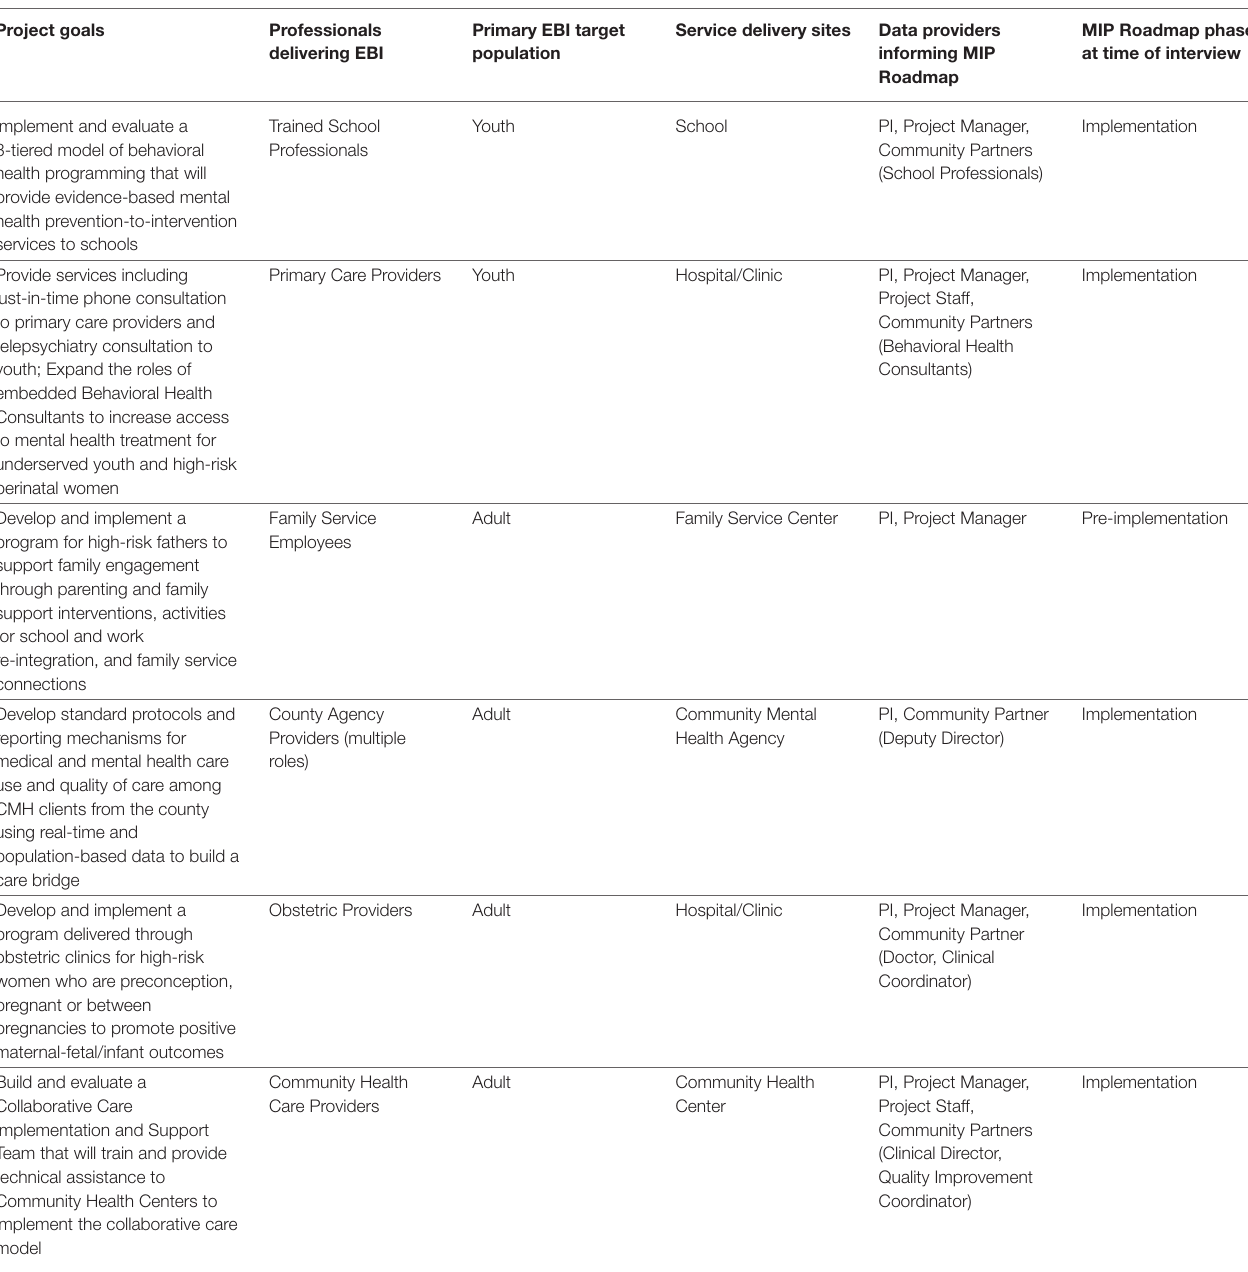
TABLE 1 | Projects (EBIs)